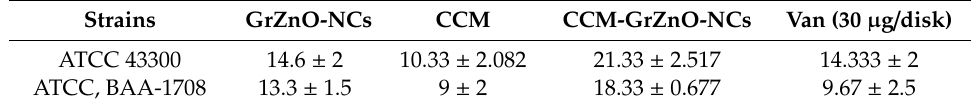
Table 1. Effect of the combination of C.C.M. and GrZnO-NCs against M.R.S.A. strains as revealed by a zone of inhibition assay determined using agar diffusion method. Zone of inhibition observed (in mm).